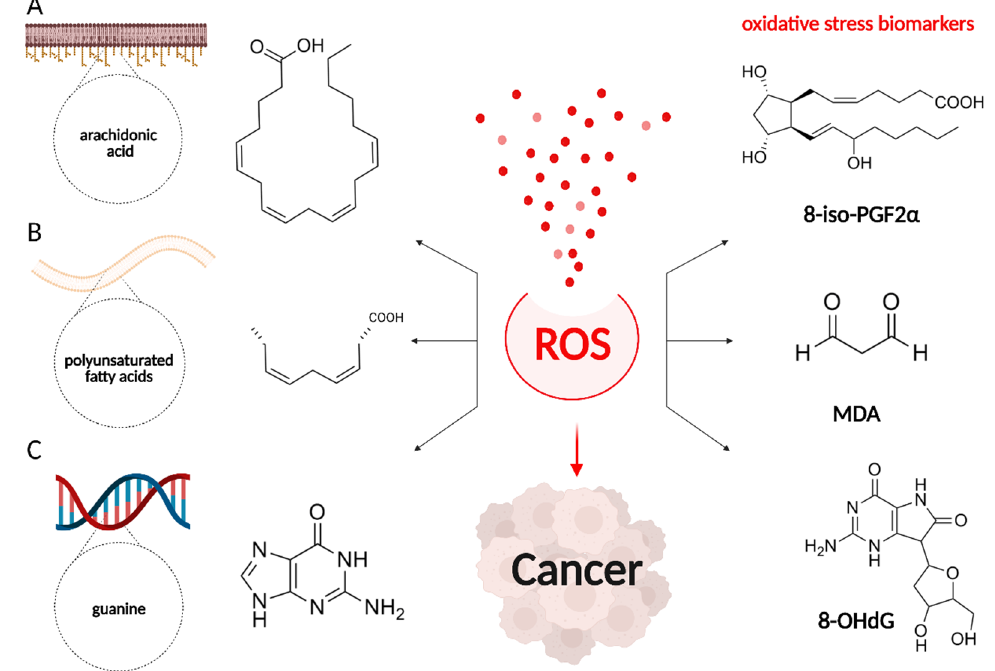
Figure 3. A schematic representation of the formation of key oxidative stress biomarkers, in which the increased level of urine or blood serum may be a sign of the formation and progression of malignant neoplasms. The steady preservation of excessive amounts of reactive oxygen species leads to aberrant oxidation of ( A ) arachidonic acid present in phospholipid membranes, resulting in the formation of 8-iso-prostaglandine F2 α (8-iso-PGF2 α ); ( B ) polyunsaturated fatty acids with the formation of malondialdehyde (MDA); and ( C ) intracellular compound and DNA component guanine, which leads to the formation of 8-hydroxy-2 ′ -deoxyguanosine (8-OHdG).